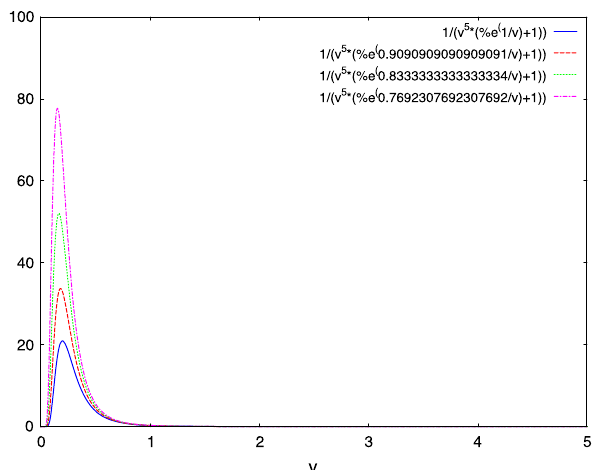
Fig. 6 A P–V diagram between holographic complexity and pressure, showing a totally different behavior than the thermodynamic P–V dia-